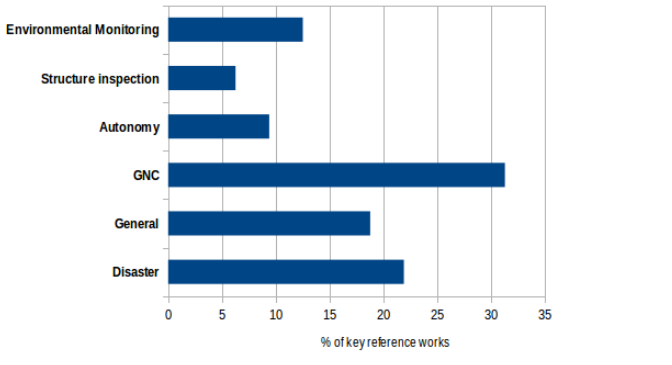
Figure 2. The distribution of surveys analyzed. From those associated with DM, only one is dedicated to UMVs, but none to USVs exclusively. Please note that if we remove works exclusively focusing on USVs from the list, the number of surveys drops to